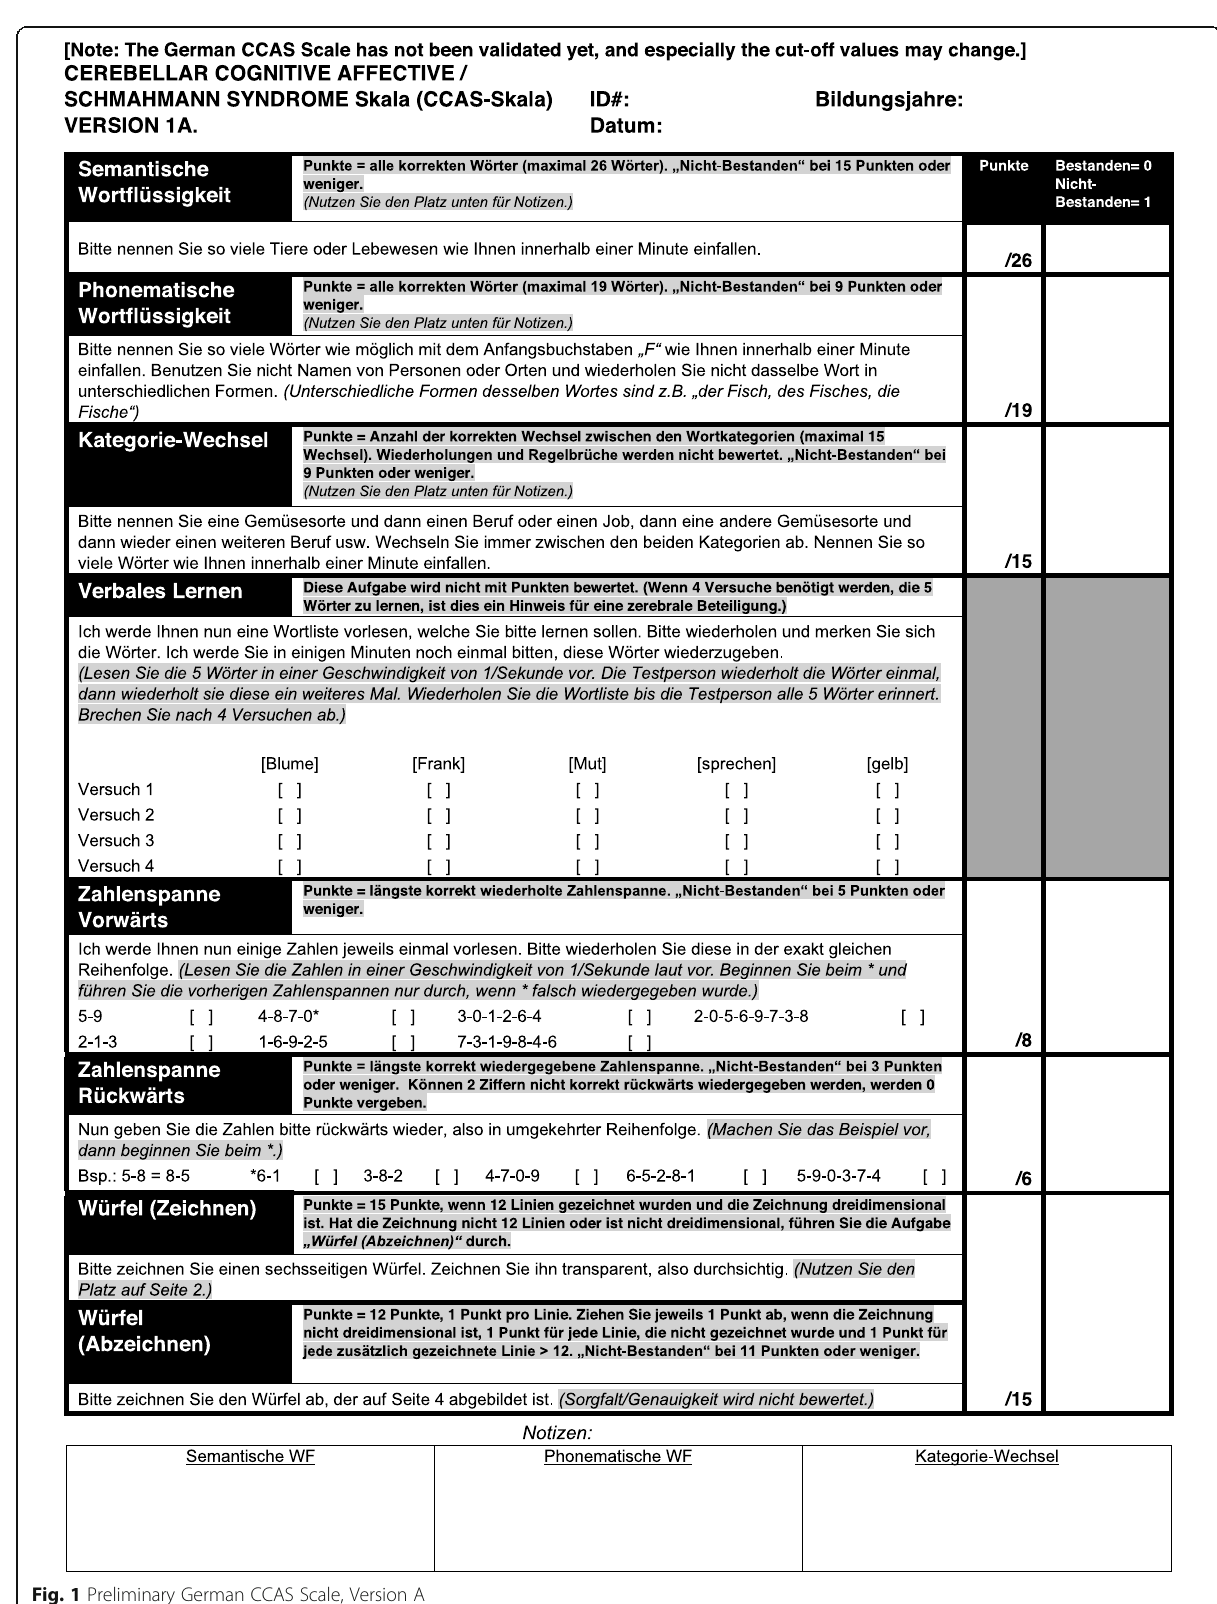
Fig. 1 Preliminary German CCAS Scale, Version